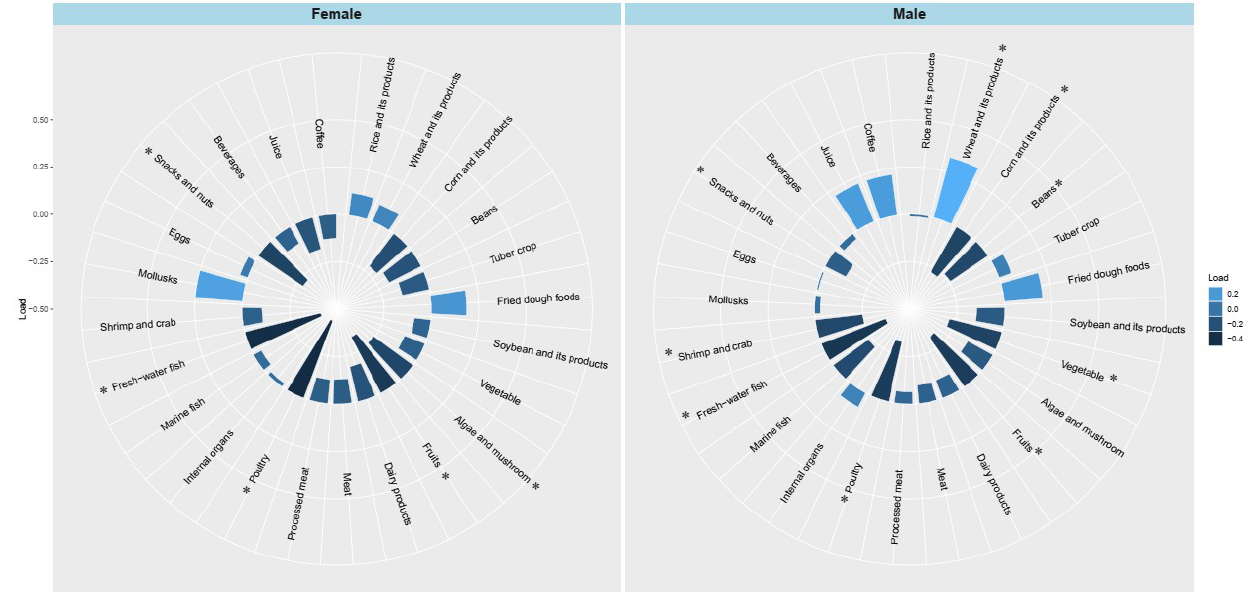
Figure 1. Factor loading of food groups for male and female participants. * Represents an absolute value of factor loading of this food group larger than